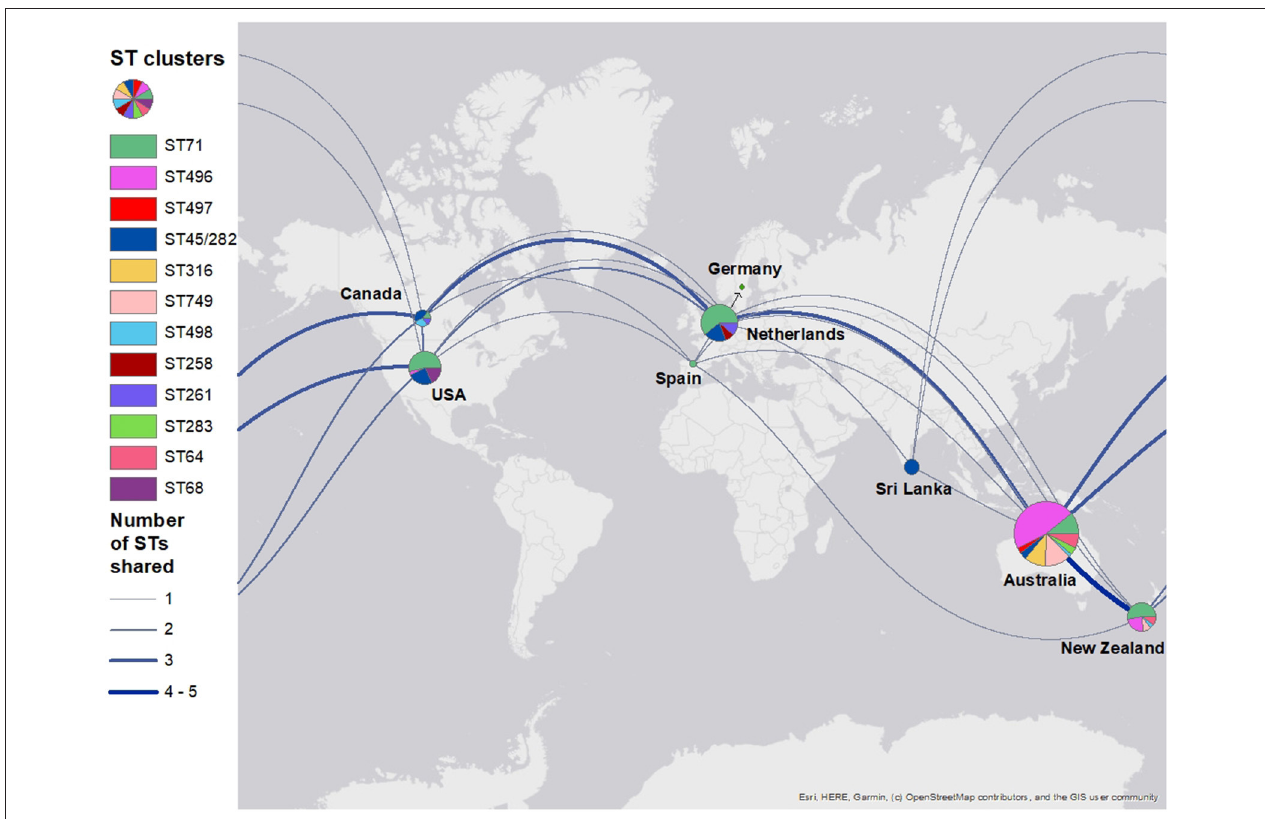
FIGURE 2 | A world map displaying shared methicillin-resistant Staphylococcus pseudintermedius sequence types among countries. Isolates were grouped into sequence type clusters according to how they clustered in a phylogenetic tree. The pie chart for Germany was covered by the Netherlands pie chart and so has been pointed out with an arrow. Pie chart sizes reflect the number of isolates from each country (i.e., a bigger chart reflects a larger number of isolates).